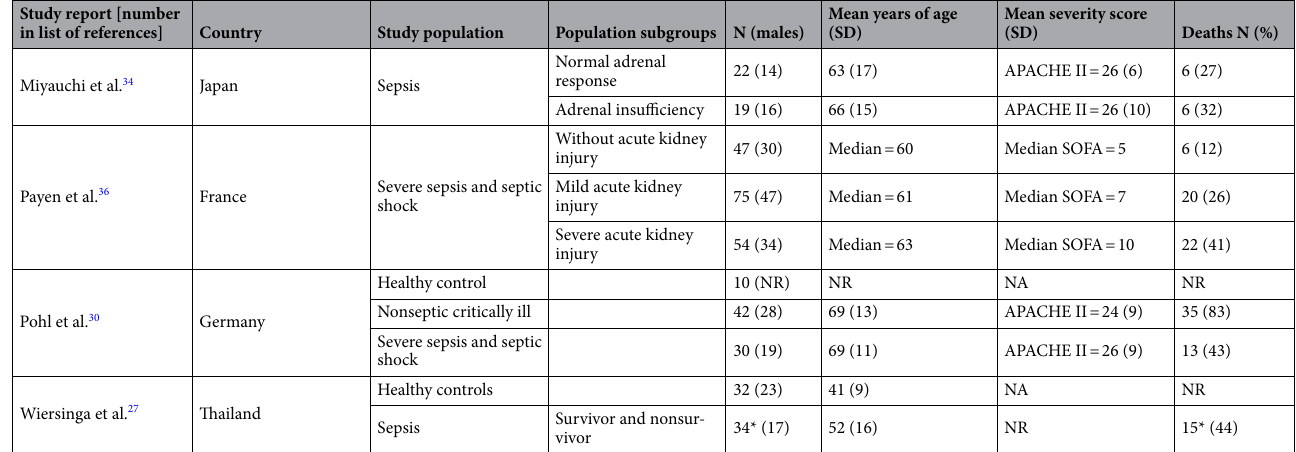
Table 1. Characteristics of participants in the studies included in the meta-analysis. *MIF levels were reported for 29 septic and 10 survivor patients. ARDS adult respiratory distress syndrome, APACHE acute physiology and chronic health evaluation score, DIC disseminated intravascular coagulation, NA not applicable, NR not reported, SAPS simplified acute physiology score, SIRS systemic inflammatory response syndrome, SOFA sequential (sepsis-related) organ failure assessment